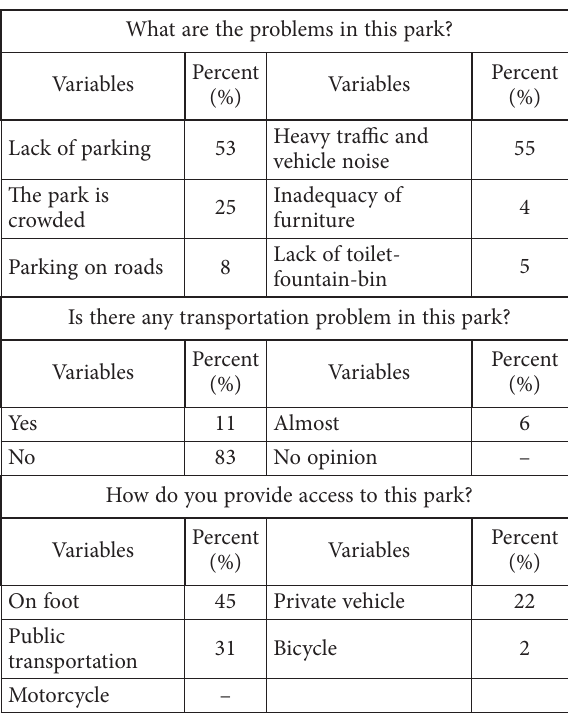
Table 10. Evaluation of park